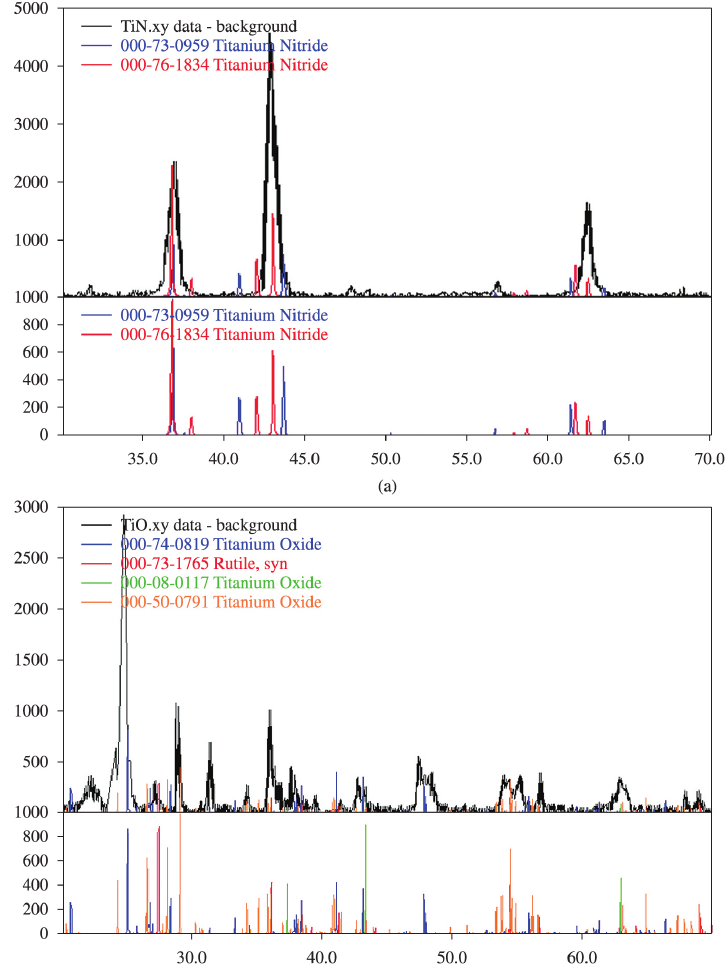
Figure 2. XRD spectra of the nanosized phases for the a) Ti-N system and b) Ti-D